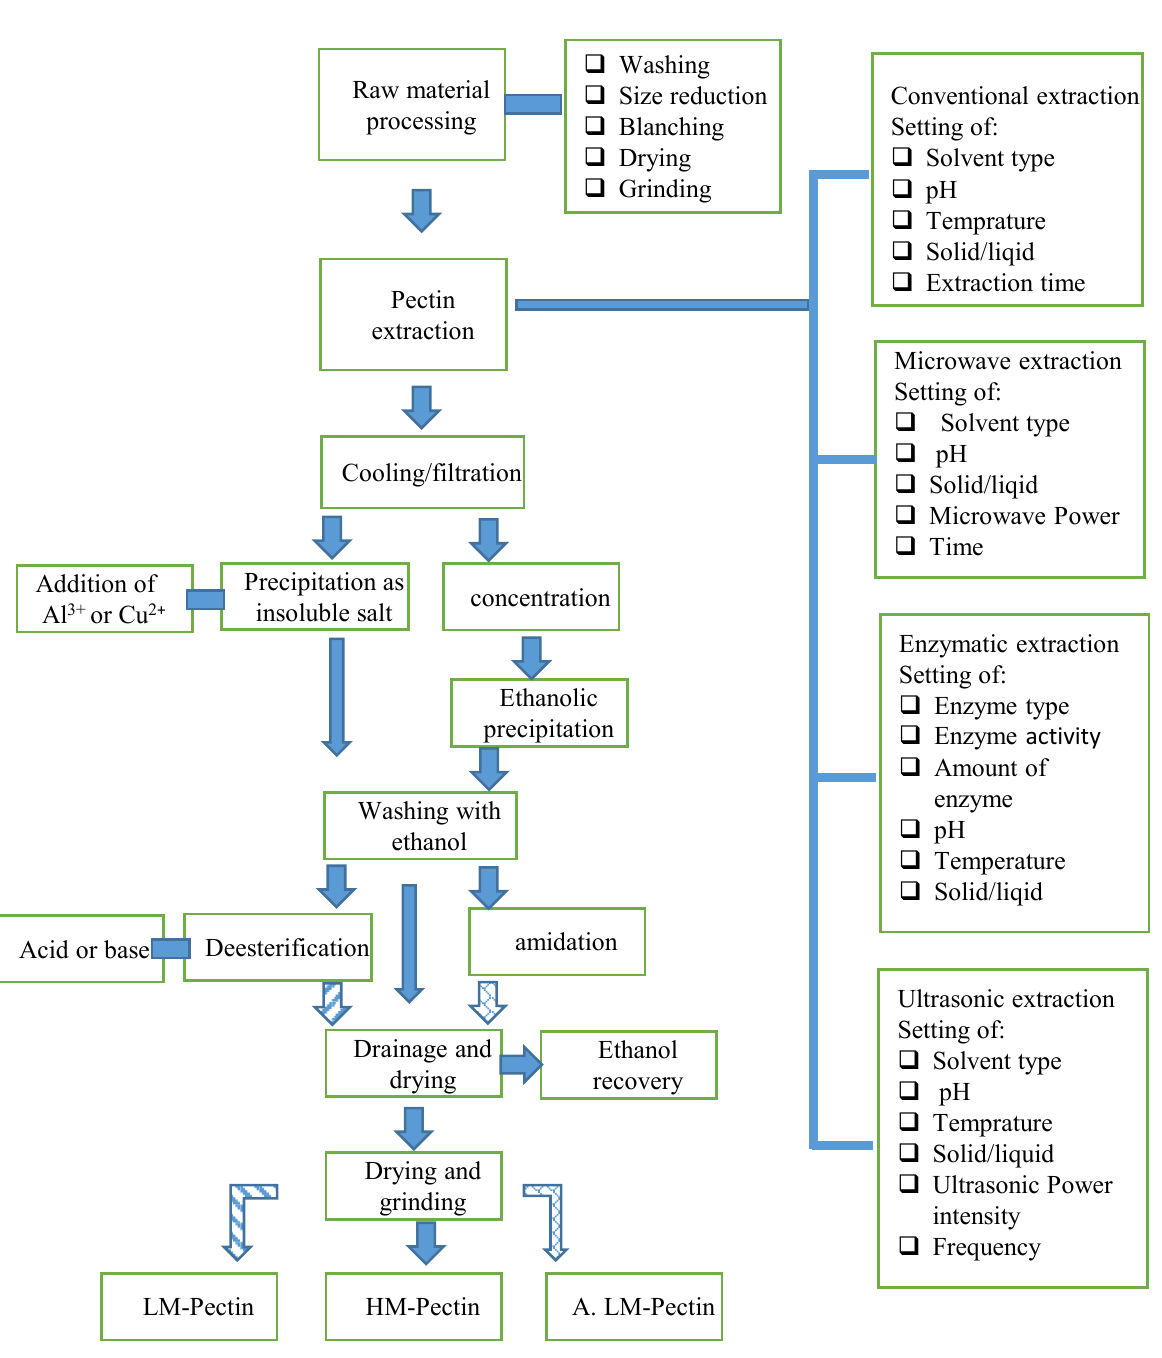
Figure 4. Pectin extraction process [71] .